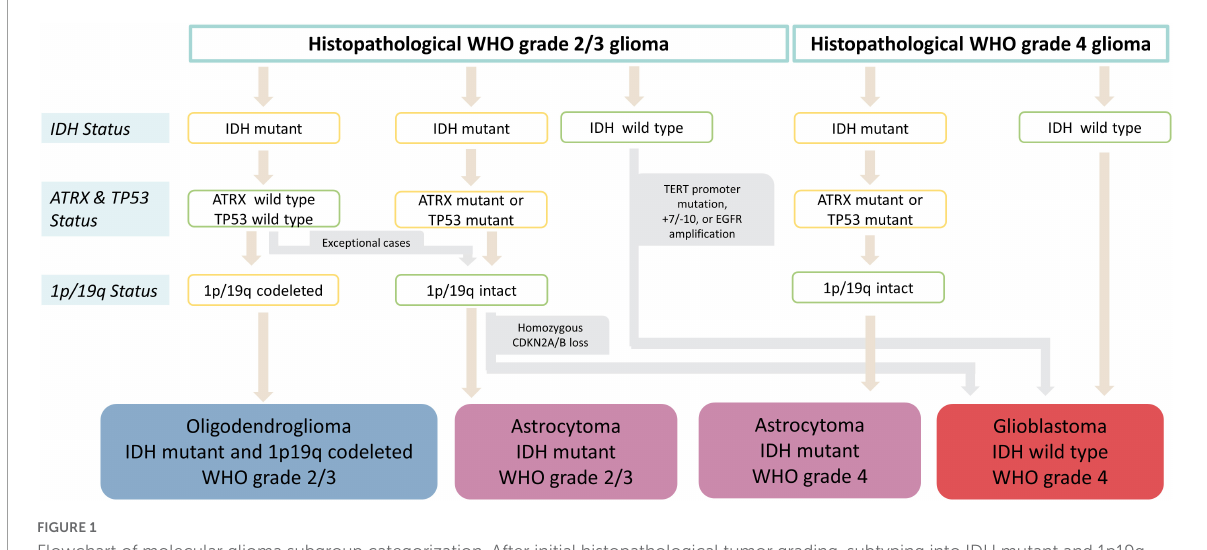
FIGURE1 Flowchart of molecular glioma subgroup categorization. After initial histopathological tumor grading, subtyping into IDH mutant and 1p19q codeleted oligodendroglioma, IDH mutant astrocytoma, IDH wild type astrocytoma and IDH wild type glioblastoma is performed according to IDH, ATRX and 1p/19q status. Furthermore, homozygous CDKN2A/B loss in IDH mutant astrocytomas as well as presence of either TERT promoter mutation, 7+/10- aneuploidy or EGFR amplification IDH in wild type gliomas results in upgrading to WHO grade 4 independently of histopathological